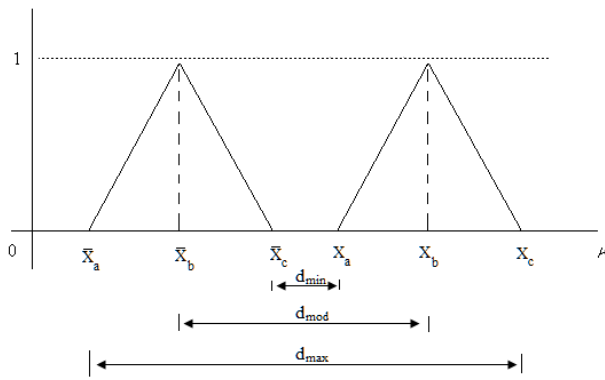
Fig. 3. The distances between fuzzy number and fuzzy mean : the fuzzy number is exactly on the right hand side of fuzzy average.